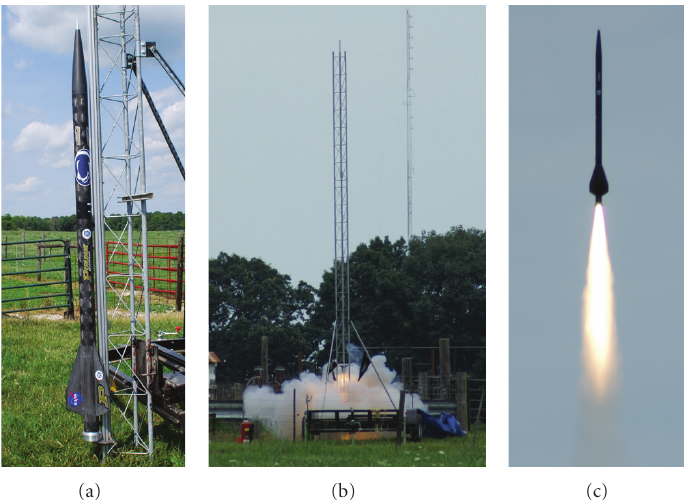
Figure 10: Images from the ALICE flight test: rocket on launch platform (a), ignition of the ALICE propellant (b), and rocket in flight (c).